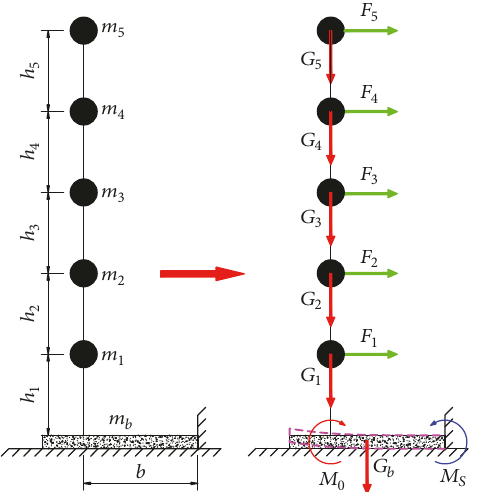
Figure 16: A mechanical calculation model considering foundation